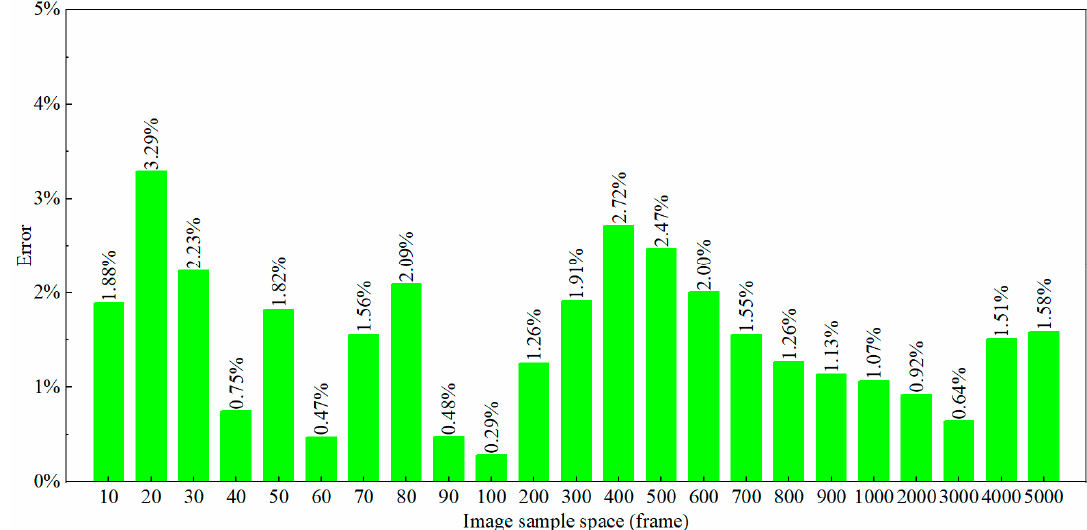
Figure 12. Calculation errors of maximum mass loss of the sample.